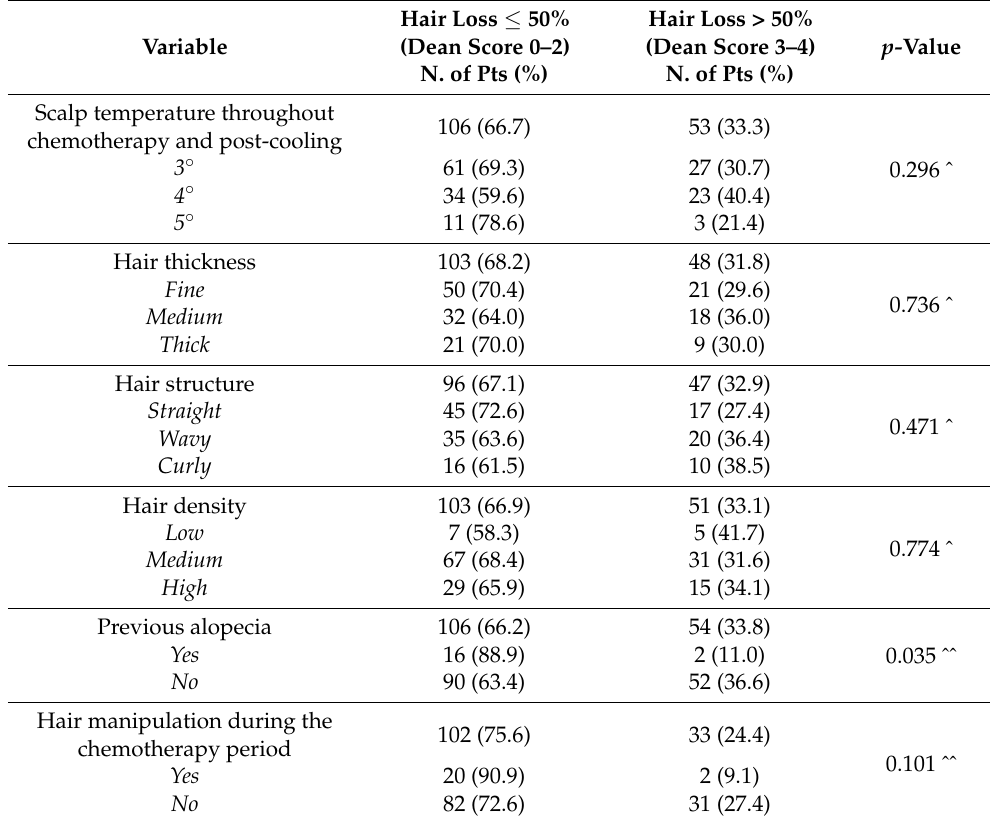
Table 2. The hair loss degree, evaluated by medical staff after the completion of all cycles of chemother- apy, according to the patient